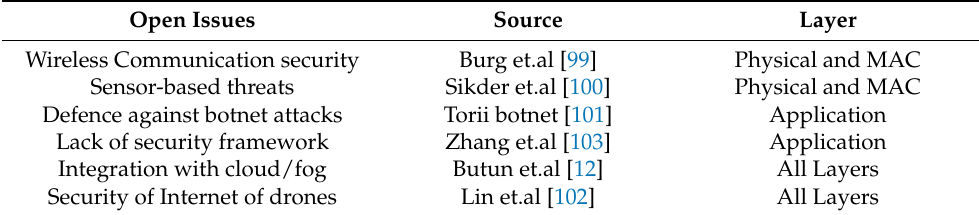
Table 7. Open Issues for cybersecurity in